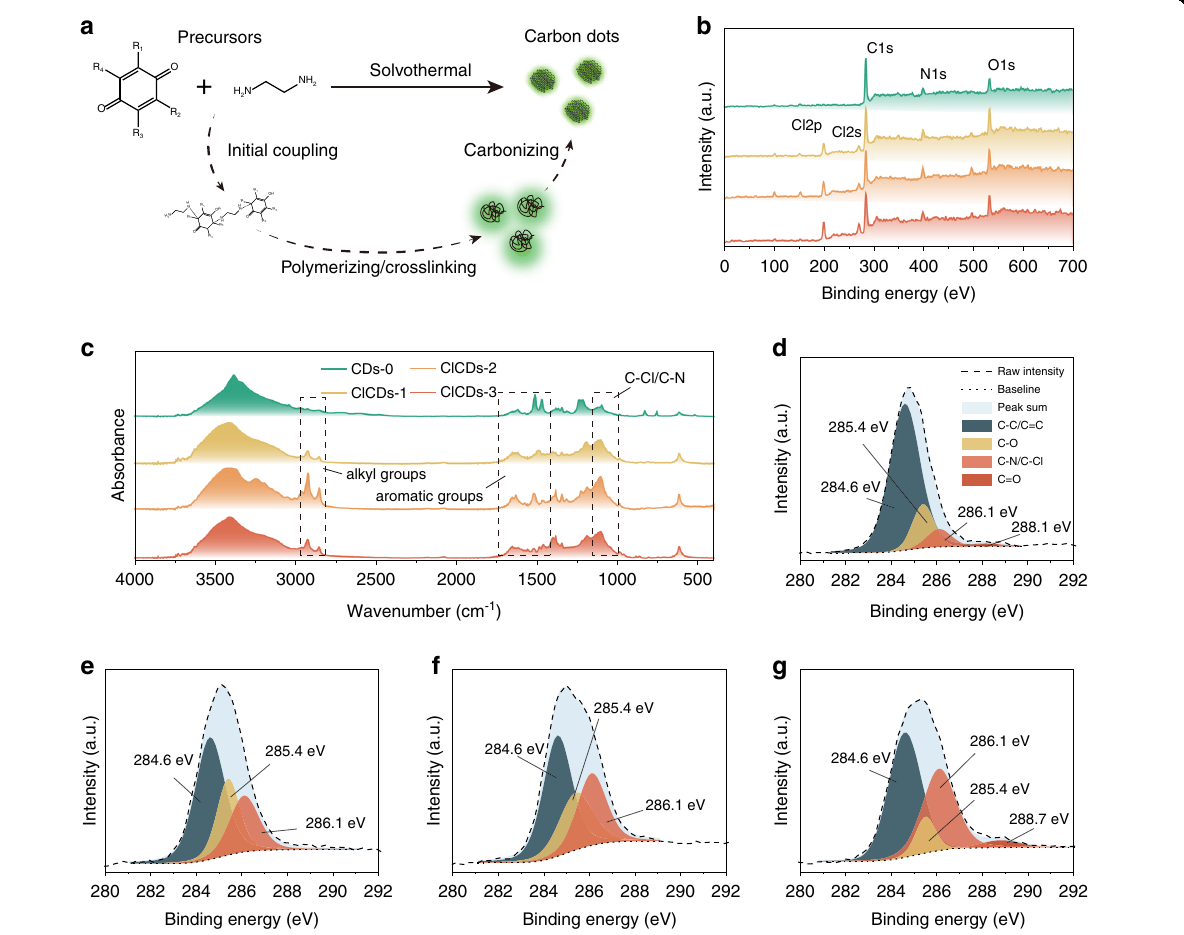
Fig. 2 Chemical compositions of CDs with different halogen contents. a Schematic illustration of the solvothermal synthesis of CDs from molecular precursors. (For CDs-0, R1 = R2 = R3 = R4 = H; for ClCDs-1, R1 = Cl, R2 = R3 = R4 = H; for ClCDs-2, R1 = R3 = Cl, R2 = R4 = H; for ClCDs-3, R1 = R2 = R3 = R4 = Cl.) b XPS survey and elemental compositions of the four CDs. c The FT-IR absorbance of the four CDs. Deconvoluted C1s binding energies of CDs-0 ( d ), ClCDs-1 ( e ), ClCDs-2 ( f ), and ClCDs-3 ( g